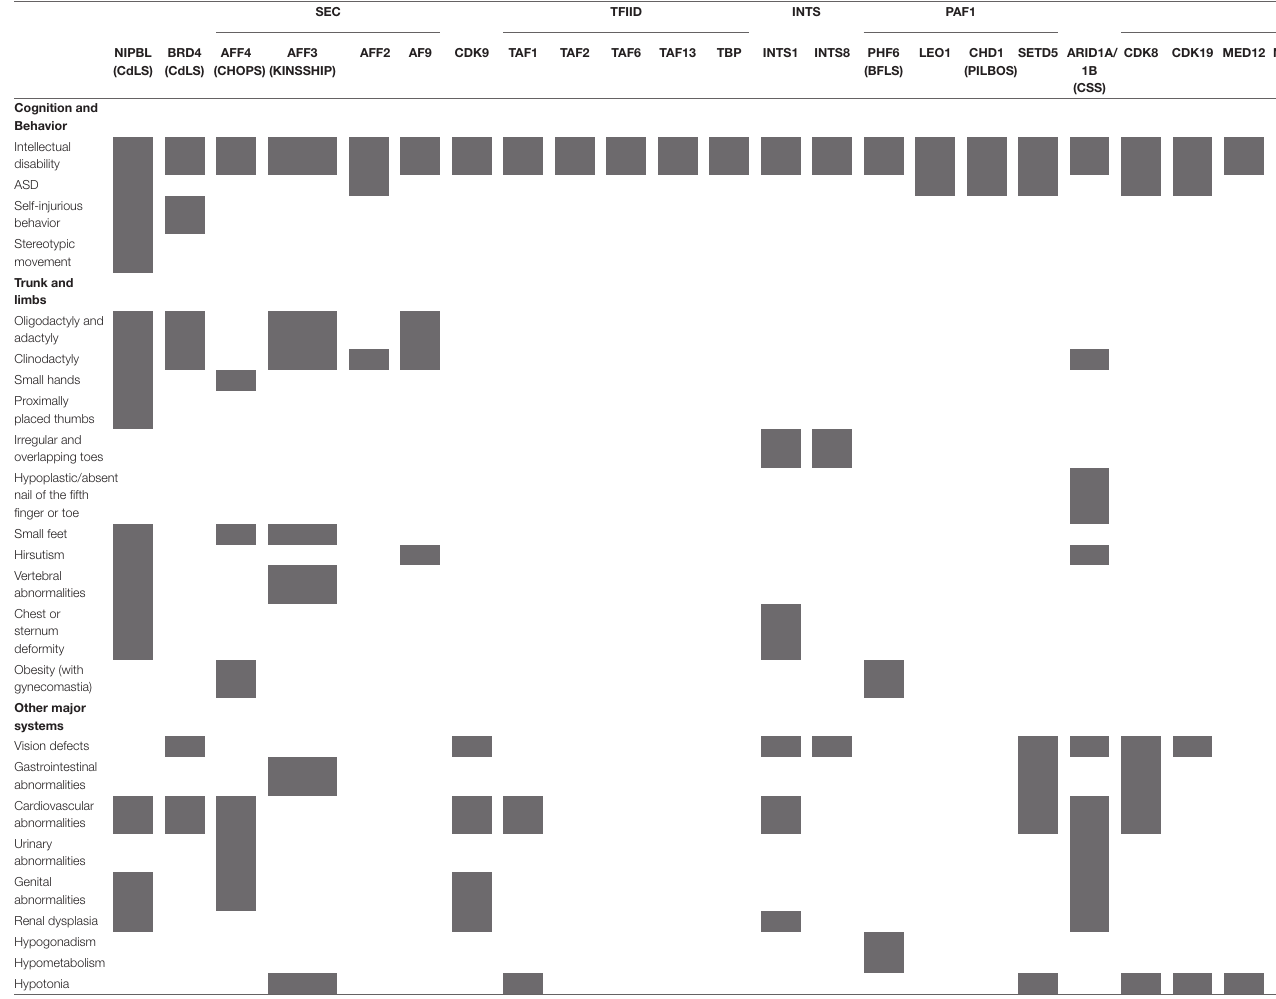
Cognitionand Behavior Intellectual disability ASD Self-injurious behavior Stereotypic movement Trunkand limbs Oligodactylyand adactyly Clinodactyly Smallhands Proximally placedthumbs Irregularand overlappingtoes Hypoplastic/absent nailofthefifth fingerortoe Smallfeet Hirsutism Vertebral abnormalities Chestor sternum deformity Obesity(with gynecomastia) Othermajor systems Visiondefects Gastrointestinal abnormalities Cardiovascular abnormalities Urinary abnormalities Genital abnormalities Renaldysplasia Hypogonadism Hypometabolism